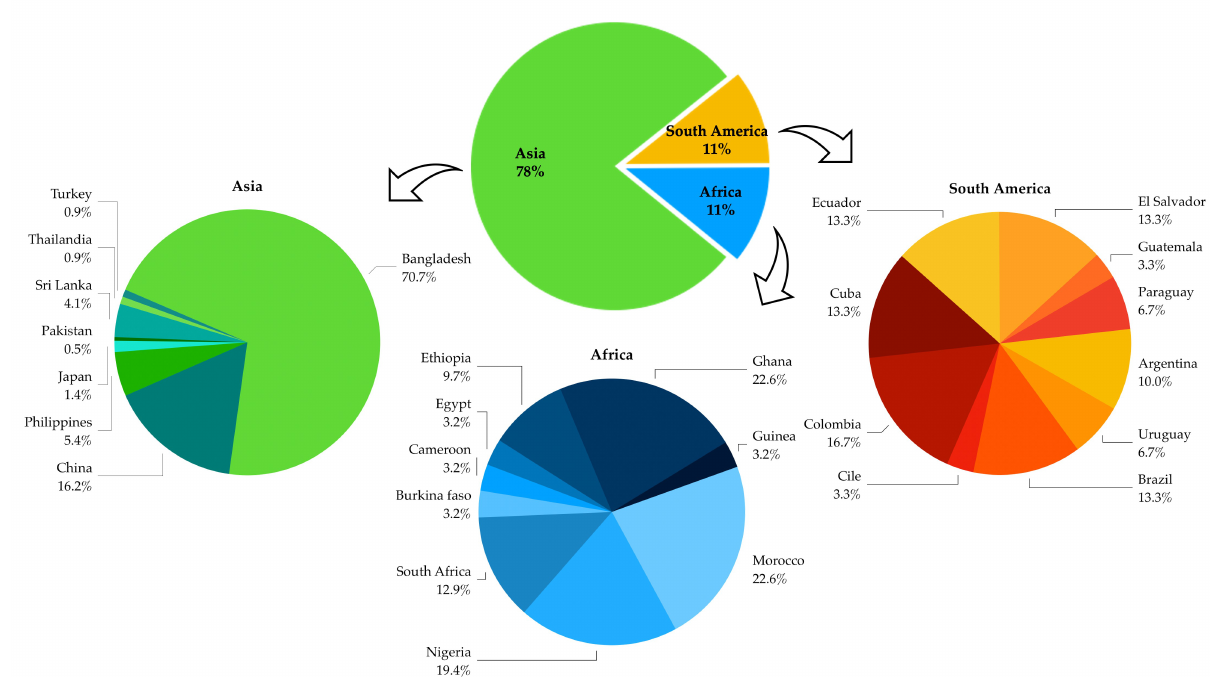
Figure 2. Country of origin of the plant material seized at the BIPs, (Turkey was included in Asian